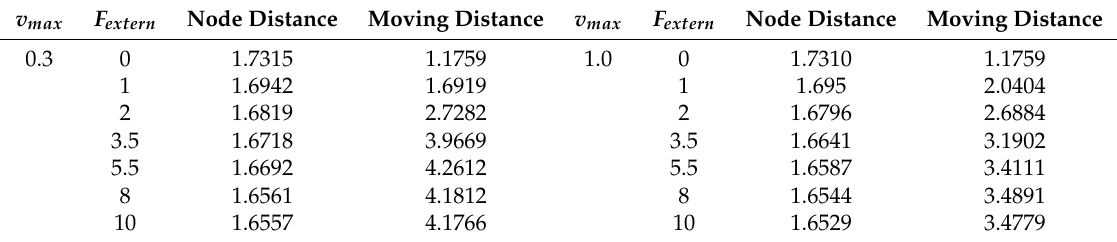
Table 4. Average equilibrium distance and average moving distance within radius = 10 for different values of external central force from the VFA-SF-OPT, when v max = 0.3, and 1.0, respectively. v max F extern Node Distance Moving Distance v max F extern Node Distance Moving Distance 0.3 0